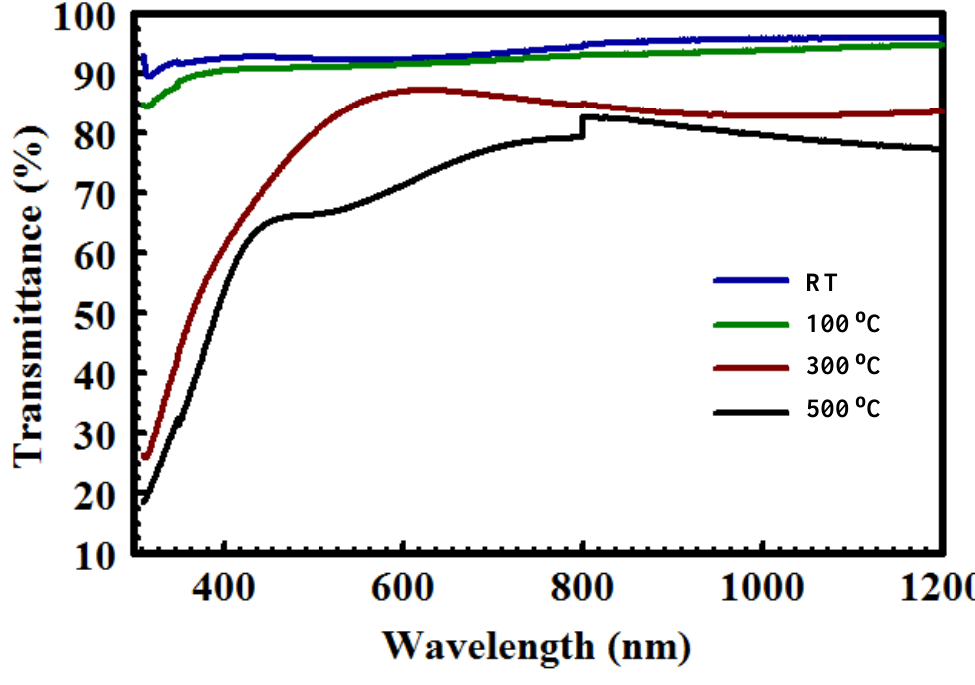
Figure 6. UV-Vis transmittance spectra obtained from Y / Sialon thin films prepared using PLD at RT, 100 °C, 300 °C, and 500 °C.